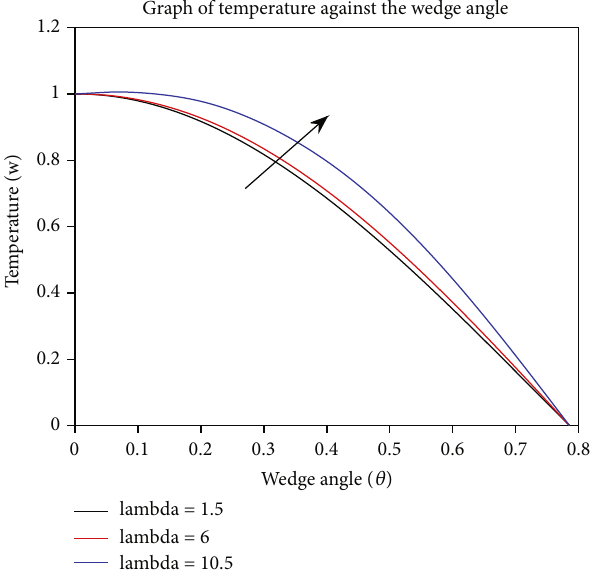
Figure 15: E ff ect of varying the unsteadiness parameter on